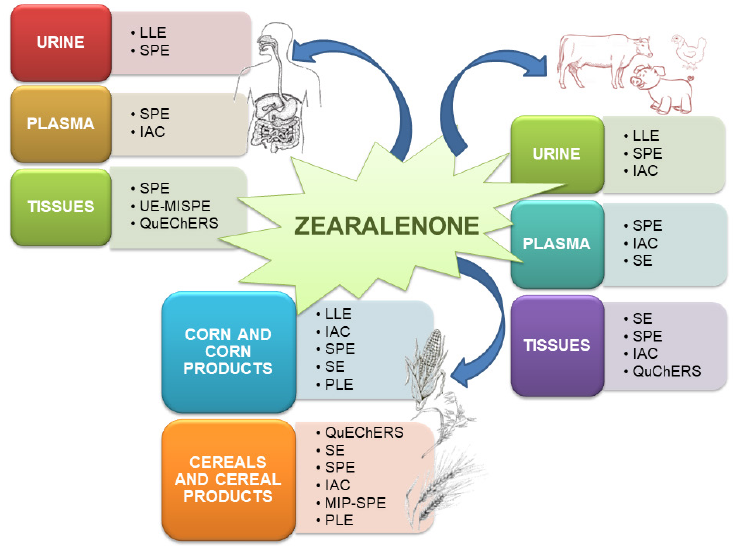
Figure 3: Various extraction techniques for isolation of zearalenone and its